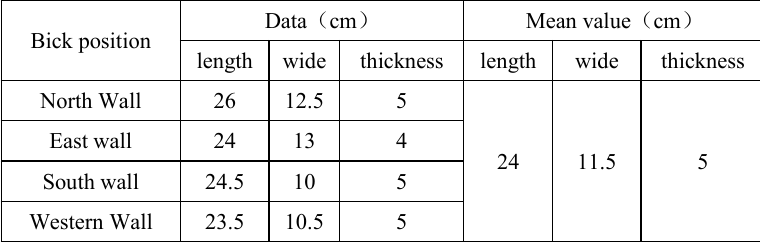
Table 1 Summary of Drum Tower City Brick Sampling Data